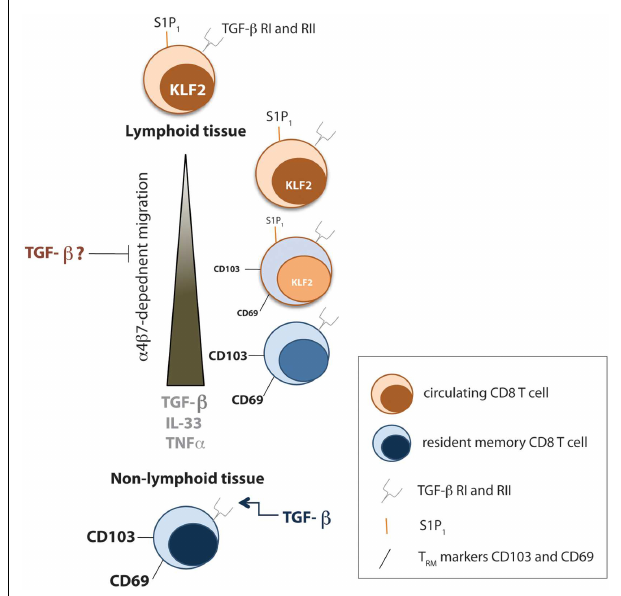
FIGURE 1 | Cytokines involved inTRM formation and maintenance . Early after infection, localTGF- β signals prevent migration of effector CD8T cells from the spleen to non-lymphoid tissue by downregulating the α Eb7 integrin. However, tissue-specific programming during priming of CD8T cells causes homing to appropriate resident tissue. In addition, the transcription factor KLF2 gets downregulated as effector CD8T cells travel to non-lymphoid tissue toward a combination ofTGF- β , IL-33, andTNF α signals, which causes a decrease in S1P1, allowing upregulation of CD69. Within resident tissue,TGF- β signals sustainTRM